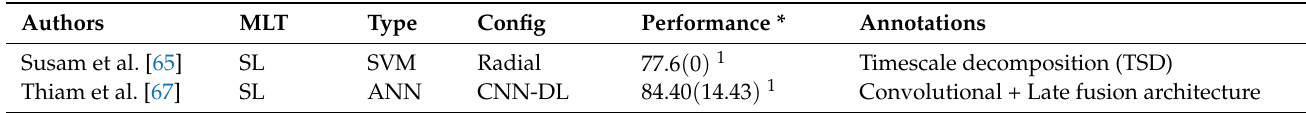
Table 14. Supervised learning methods for physical pain